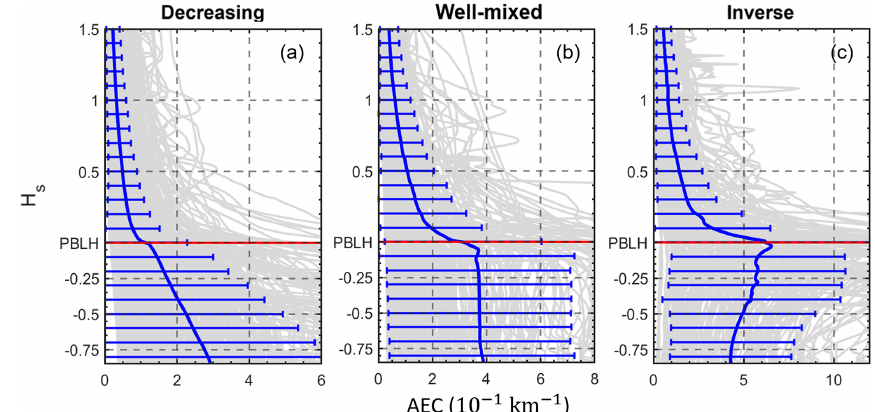
Figure 4. Normalized vertical profiles of the aerosol extinction coefficient (AEC) for (a) decreasing, (b) well-mixed, and (c) increasing (i.e., inverse) aerosol structures. The red line marks the position of the PBLH, the solid blue lines represent the average profiles of corresponding profiles, and error bars represent the standard deviations.